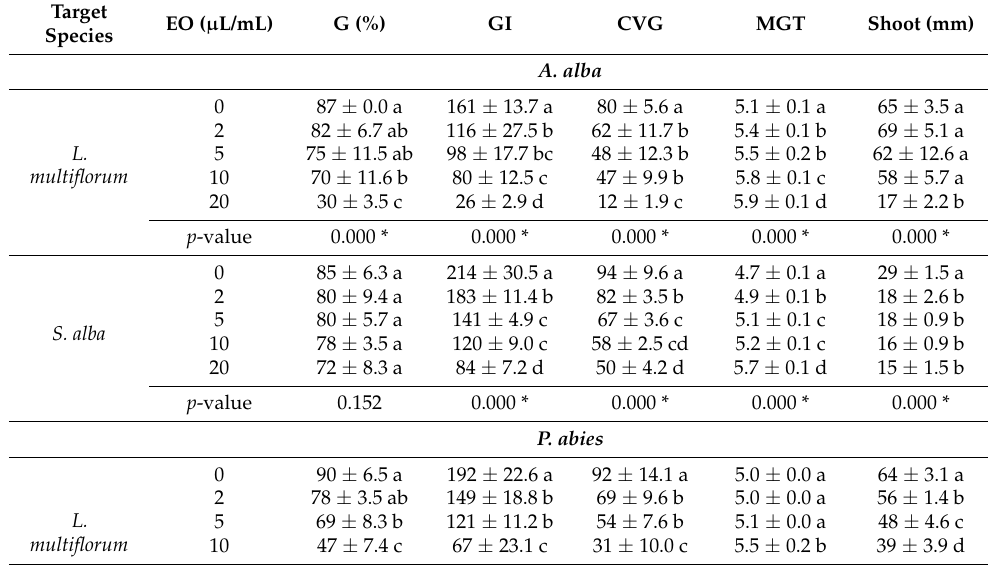
Table 4. Germination and growth values of two target species under the phytotoxic effects of different concentrations of EOs (liquid phase) in pre-emergence